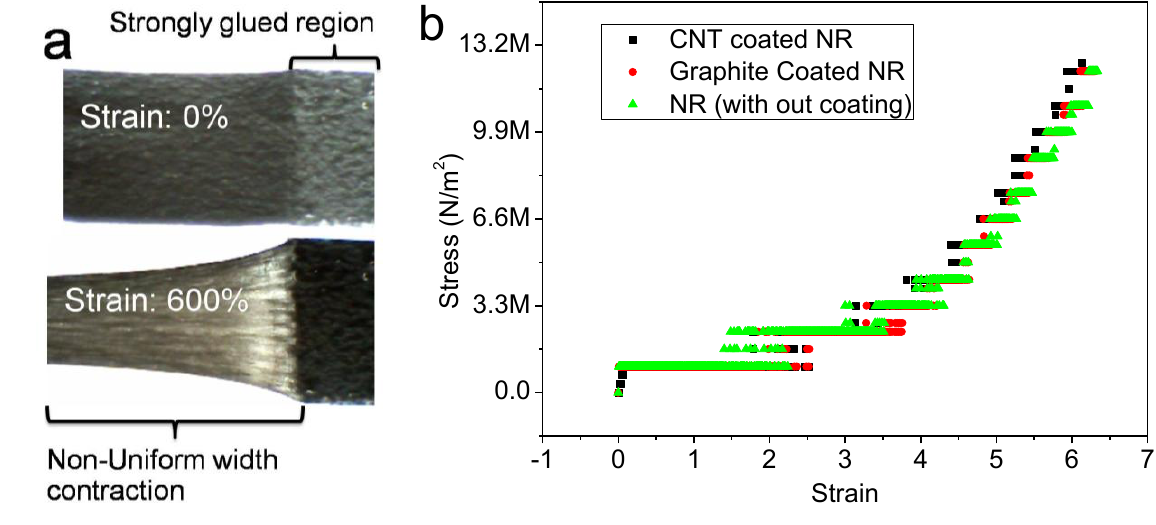
4. Nonlinearity: ( a ) Non-uniform deformation of the strained conducting layer/substrate; ( b ) Stress versus strain curves for the MWCNT, graphite coated, and uncoated NR